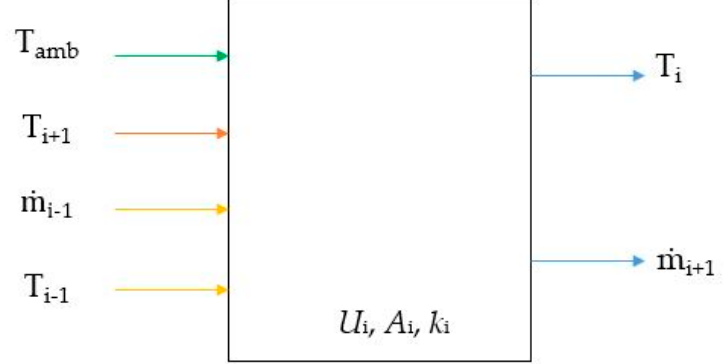
Figure 4. Main input and output parameters for ith node.